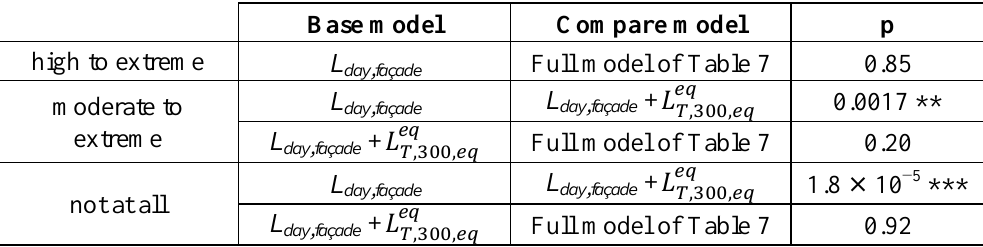
Table 8. p value in ANOVA chi squared test comparing different models for predicting reported street traffic noise annoyance